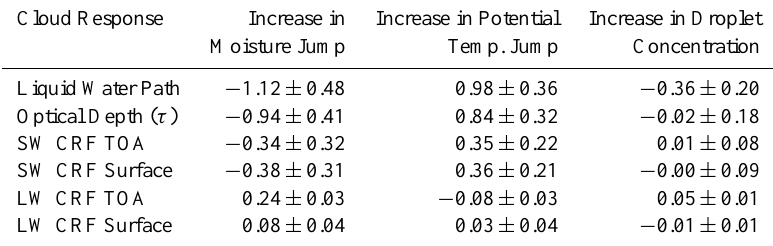
Table 6. Sensitivities of cloud response (liquid water path, optical depth and cloud radiative forcing) to perturbations (moisture and potential temperature jumps, cloud droplet concentration). These domain-averaged values are computed as d lncloud response for each 5-minute time d lnperturbation period and for each perturbation (two per 5-min average). Means and standard deviations are two responses per 5-minute average and over all four hours of simulation time. Cloud Response Increase in Increase in Potential Increase in Droplet Moisture Jump Temp. Jump Concentration Liquid Water Path − 1.12 ± 0.48 0.98 ± 0.36 − 0.36 ± 0.20 Optical Depth ( τ